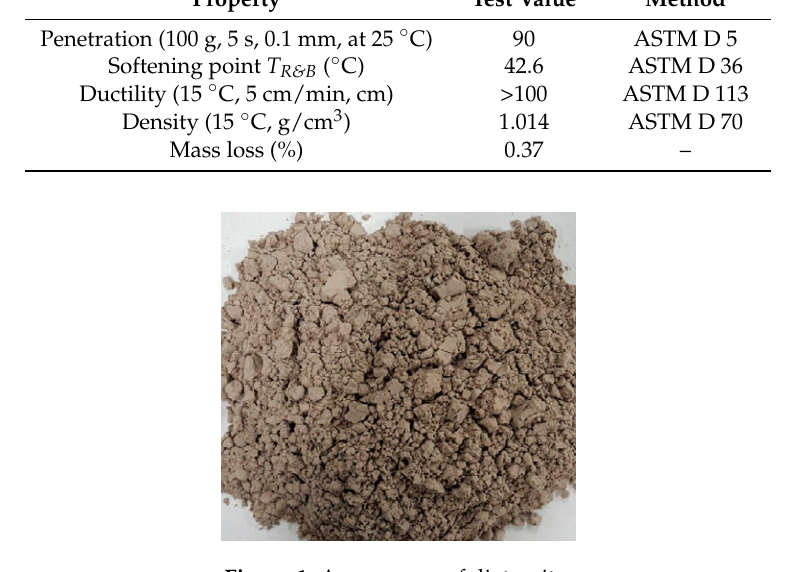
Figure 1. Appearance of diatomite. Table 2. Basic properties of diatomite.